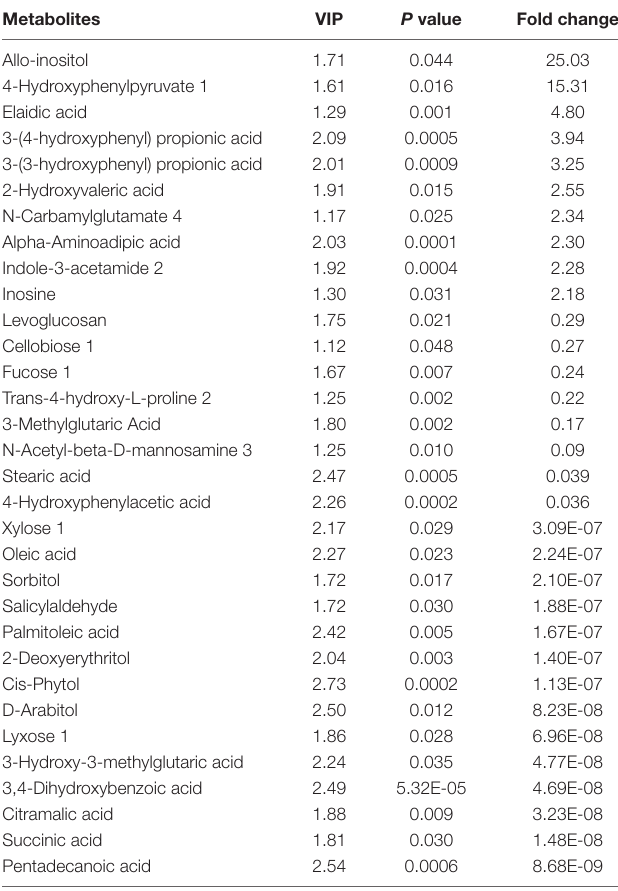
Frontiers in Microbiology |